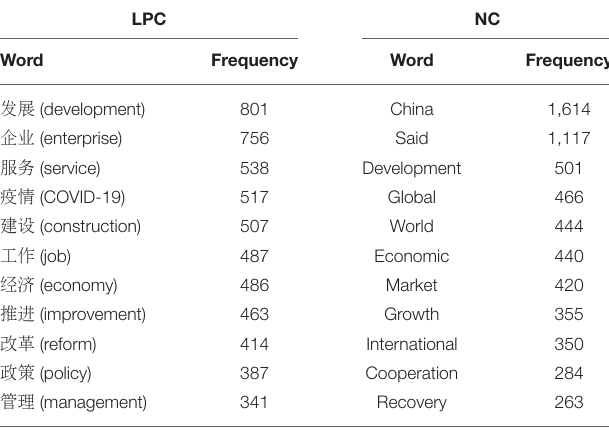
TABLE 9 | Content words ranked top eleven in frequency in the two corpora.